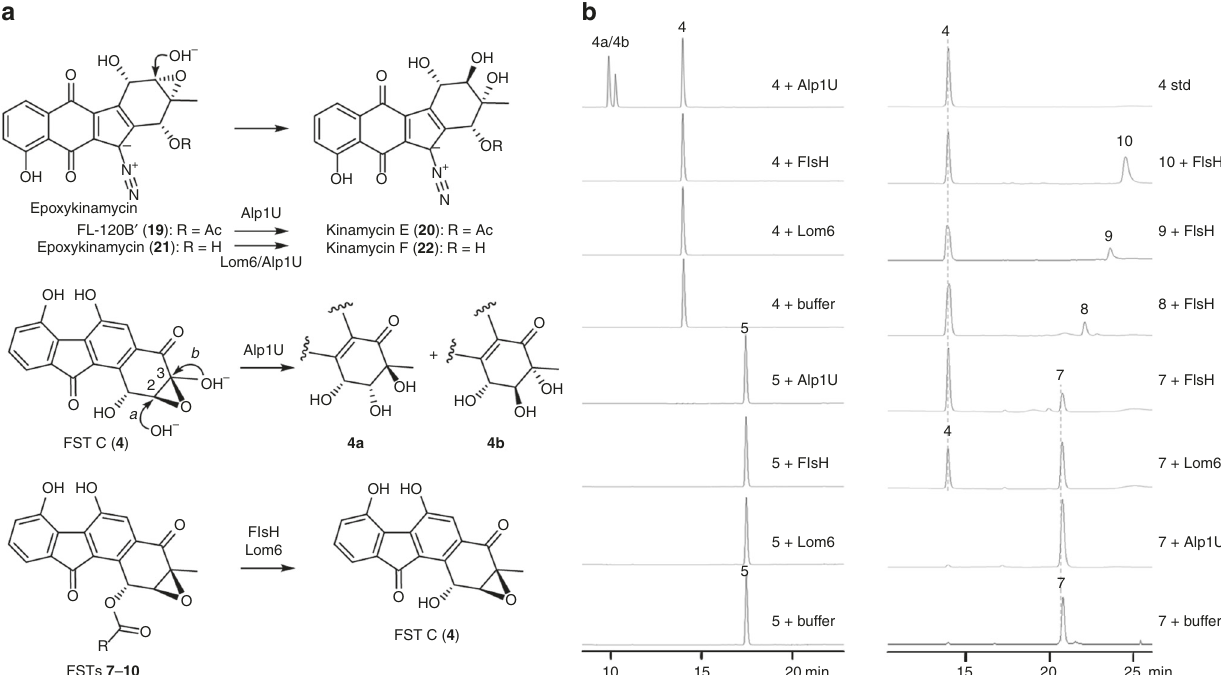
Fig. 3 In vitro characterization of Alp1U, Lom6, and FlsH. a Scheme for Alp1U, FlsH, and Lom6 catalyzed reactions. b HPLC analysis of in vitro reactions of Alp1U, FlsH, and Lom6. Each enzyme assay was performed in 100 µ L of 50 mM phosphate buffer (pH 7.0) containing 100 µ M substrate ( 4 , 5 , or 7 – 10 ) and 10 µ M enzyme (Alp1U, Lom6 or FlsH) for 30 min at 30